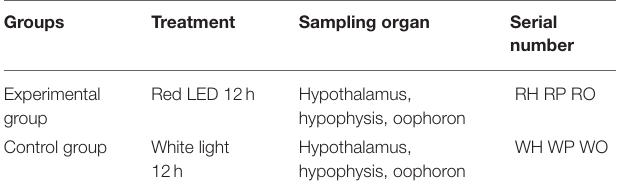
TABLE 1 | Experimental grouping and sampling